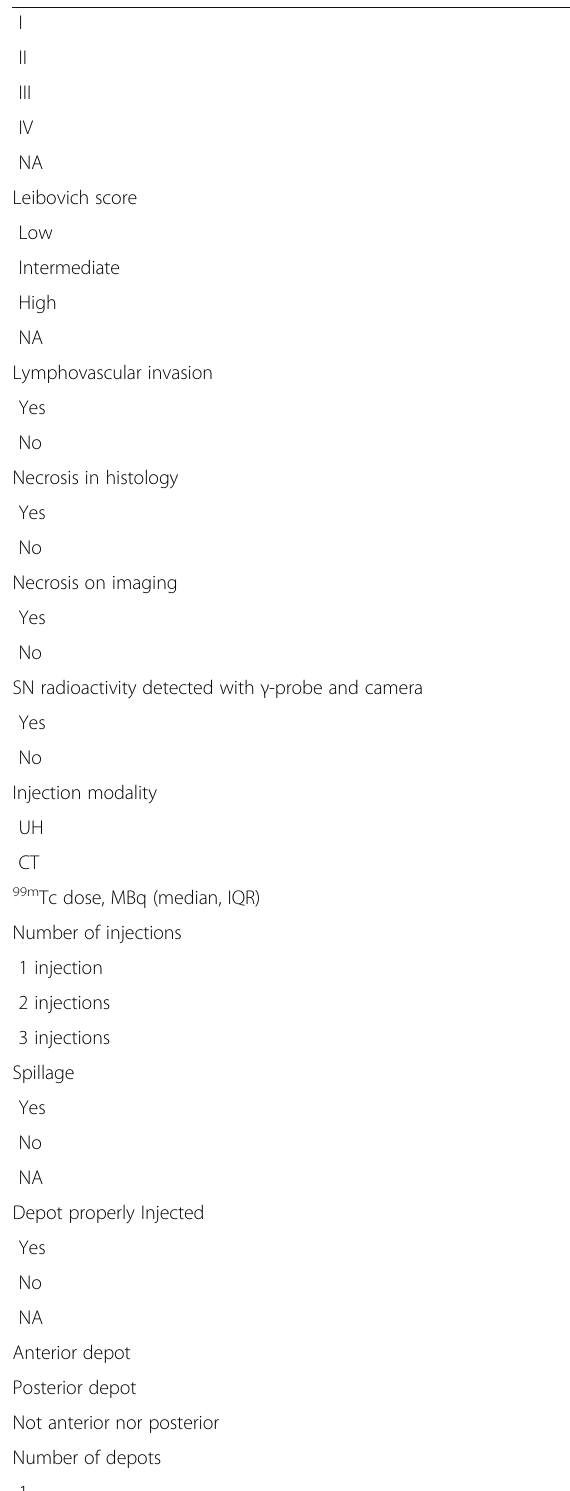
Visualization N and % or median and